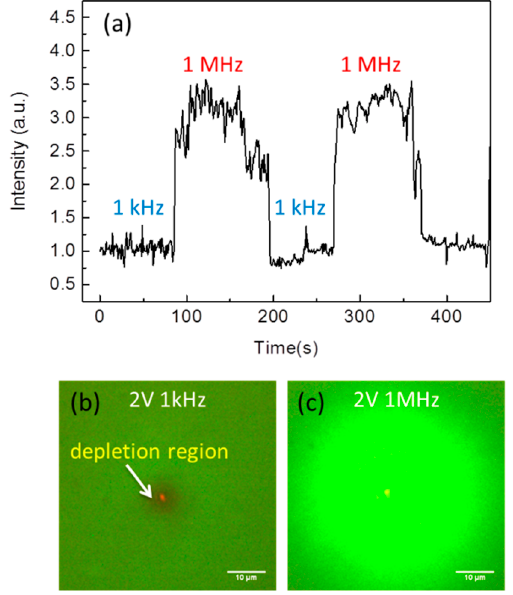
Figure 4. Ti/Al coating fiber was utilized to detect E. coli in water. ( a ) The transmission intensity for different frequency. The AC voltage was 2 V and the input frequency was switched back and forth between 1 kHz to 1 MHz. The fluorescence images of green fluorescent protein (GFP) E. coli under; ( b ) 1 kHz to ( c ) 1 MHz frequencies.